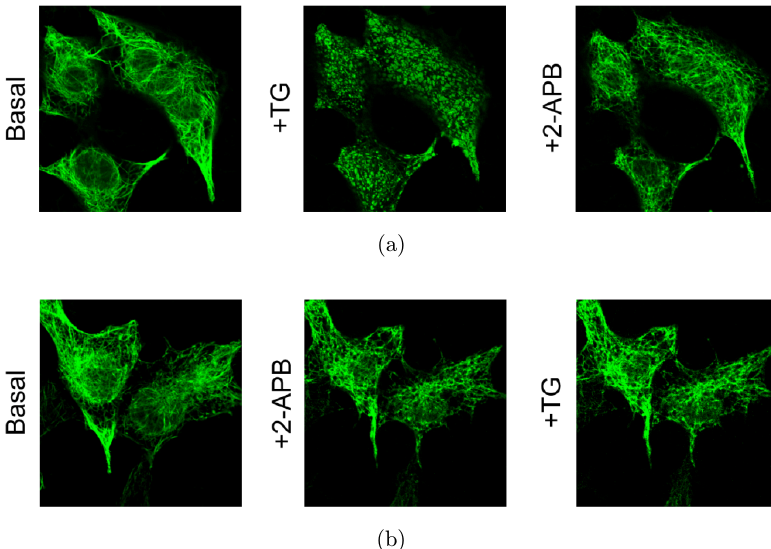
Fig. 2. 2-APB dose-dependently inhibits or reverses rearrangement of STIM1. (a) 50 (cid:1) M 2-APB reverses near plasma membrane punctate STIM1 localization in HEK293 cells. eYFP-STIM1-expressing HEK293 cells were examined in a confocal microscope at the cell footprint with replete Ca 2 þ stores (left) following store depletion with 2 (cid:1) M TG (middle) and 5min following treatment with 50 (cid:1) M 2-APB (right). (b) 50 (cid:1) M 2-APB inhibits the formation of STIM1 puncta in near plasma membrane. Confocal imaging was carried out in experiments in which cells expressing eYFP-STIM1 were pretreated with 50 (cid:1) M 2-APB for 5 min prior to store depletion with TG. (c) Time-lapse confocal imaging at the cell footprint was performed on eYFP-STIM1-expressing cells. Shown are °uorescence intensity ratio ( F / F 0) pro¯les for 0, 25, 50, and 100 (cid:1) M 2-APB-treated cells. As indicated, cells were treated with 2 (cid:1) M TG followed 5 min later by application of various concentration 2-APB in the 0 mM extracellular Ca 2 þ bath solution. (d) Confocal imaging was performed on live cells as described in (c), but 2-APB was added before store depletion with TG. (e) Left and right bar graphs show the change of confocal °uorescence intensity ratio from various concentration 2-APB-treated experiments shown in (c) and (d),